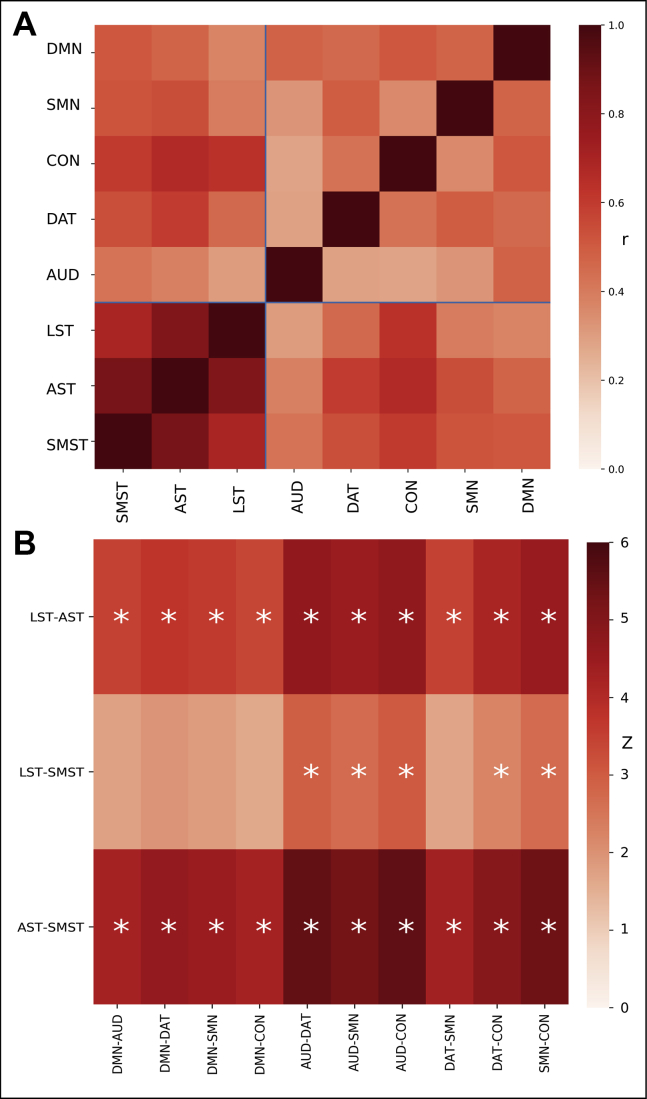
Comparison of connectivity-defined and anatomically defined subdivisions. (A) Heatmap displaying correlation coefficients between Kicer values for different subdivisions. There is greater orthogonality between connectivity-defined subdivisions (auditory network [AUD], dorsal attention network [DAT], cingulo-opercular network [CON], sensorimotor network [SMN], default mode network [DMN]) (rp = .23–.67) compared with anatomically defined subdivisions (limbic striatum [LST], associative striatum [AST], sensorimotor striatum [SMST]) (rp = .71–.91). (B) Comparing the magnitude of these intramethod correlation coefficients, these are significantly lower (∗p < .05) for the connectivity-based method (i.e., indicating greater orthogonality) for all but 5 of the 30 comparisons.